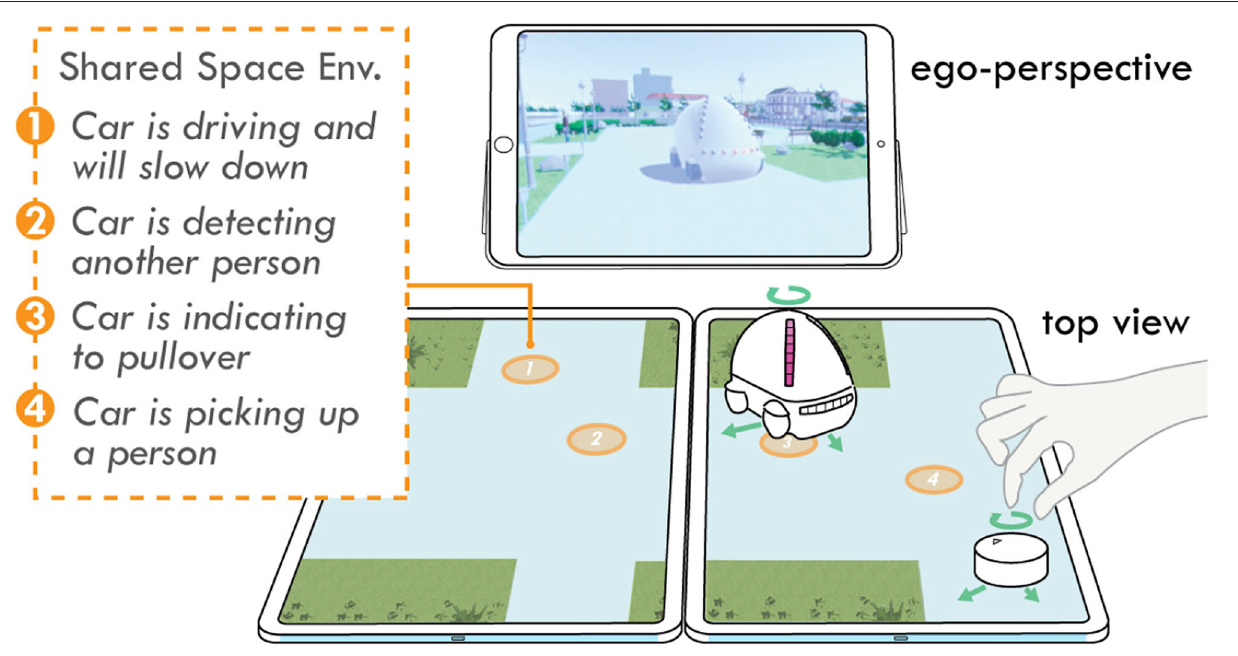
FIGURE 2 | The tangible multi-display toolkit used to inform the eHMI visualization design via computer simulations across multiple displays to capture different viewing angles, tangible objects to interact with the simulated environment and to depict the eHMI’s behavior through an integrated miniature LED